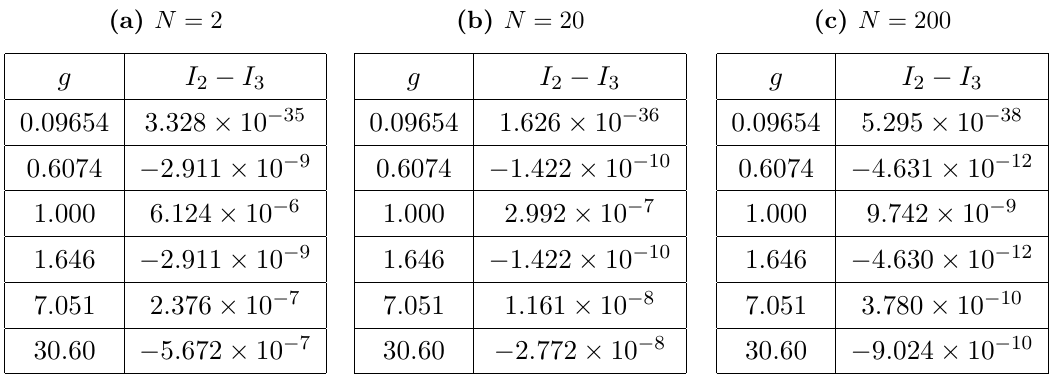
Table 1. The di(cid:11)erence between including the instanton correction and not including it at